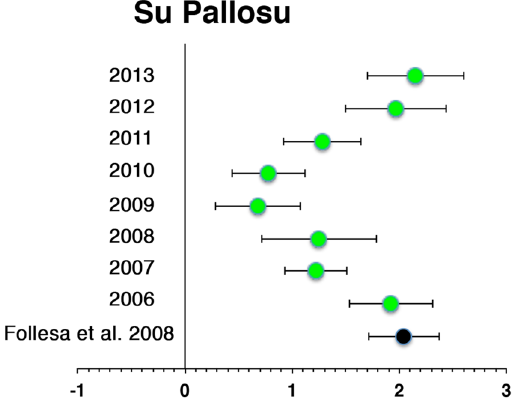
Figure 5. Forest Plot showing cumulative impacts in Su Pallosu FPA (ln–response ratio; mean ± 95% confidence intervals). Red circles: overall ratio reported in the pilot study started in 1998 and concluded in 2005; green circles: significant ratios from year 2006 to